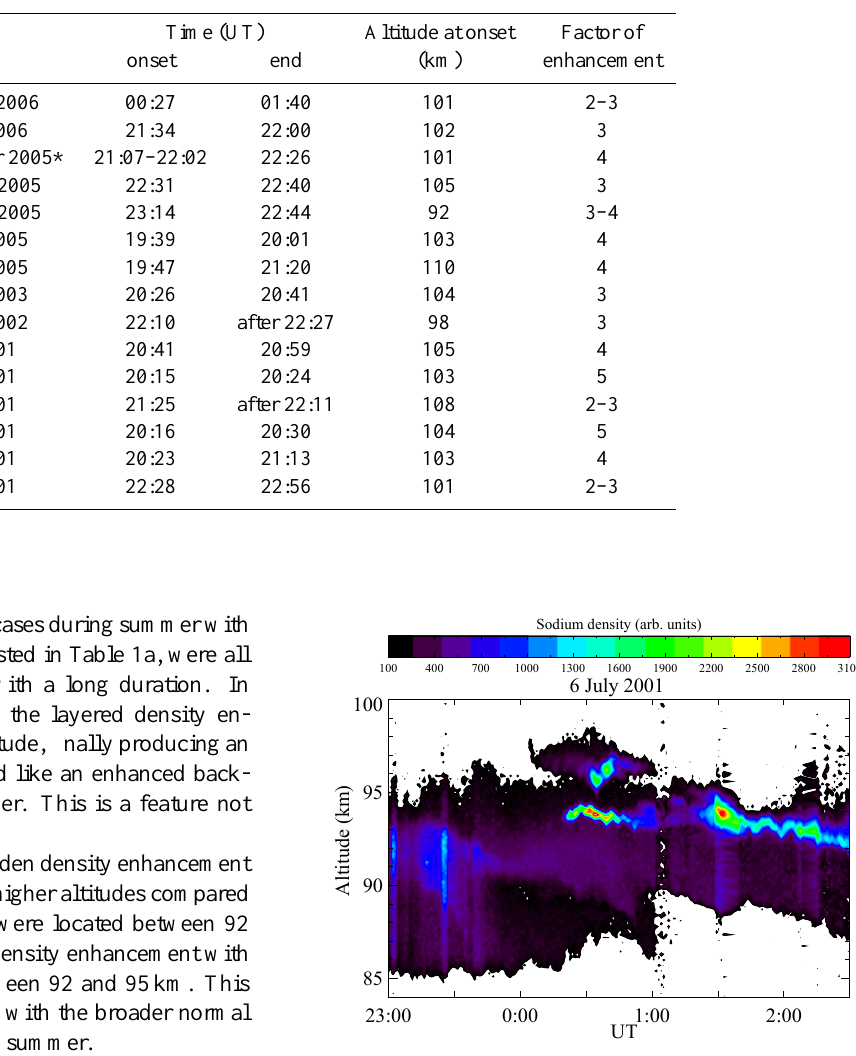
Table 1b. Observations of sudden Na layers above ALOMAR from November until March.